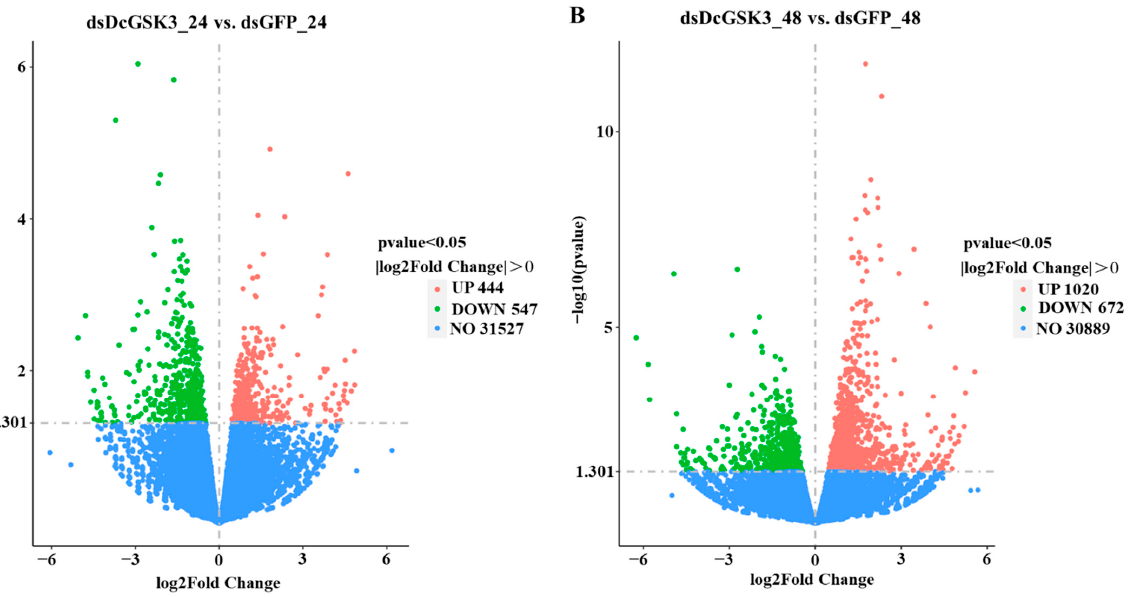
Figure 9. Identification of DEGs at 24 h and 48 h between ds DcGSK3 groups and ds GFP groups. ( A ) Identification of DEGs at 24 h between ds DcGSK3 groups and ds GFP groups. ( B ) Identification of DEGs at 48 h between ds DcGSK3 groups and ds GFP groups. The red and green points represent upregulated genes and downregulated genes, respectively. The blue point indicates no significant difference.